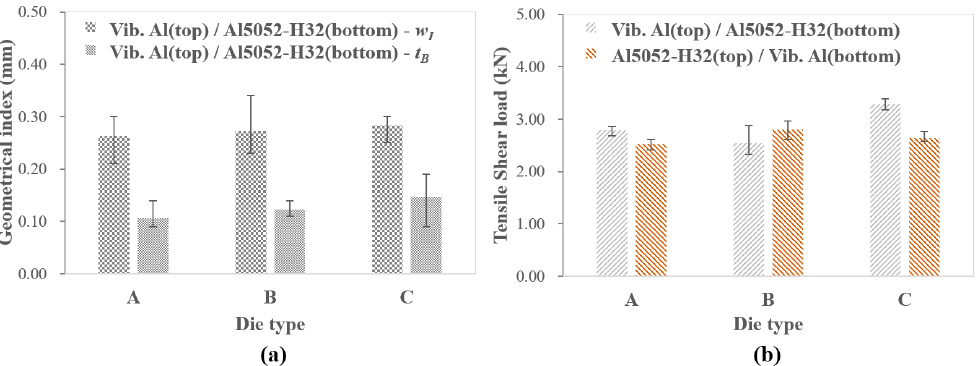
Figure 7. ( a ) The interlock width and the bottom thickness, and ( b ) tensile shear loads for the self-piercing riveted joint between vibration-damping Al and Al5052-H32 with respect to die types.